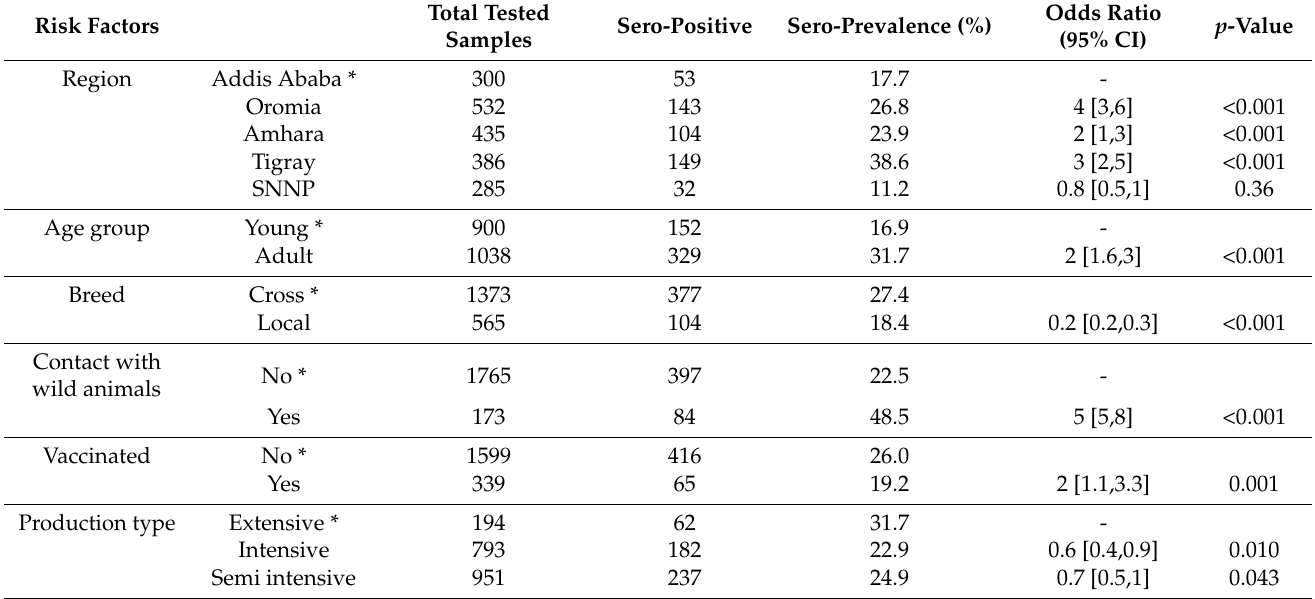
Table 4. Factors associated with FMD sero-positivity using multivariable logistic regression analysis in cattle (2018 to2020) ( N = 1938). Risk factors and their association with